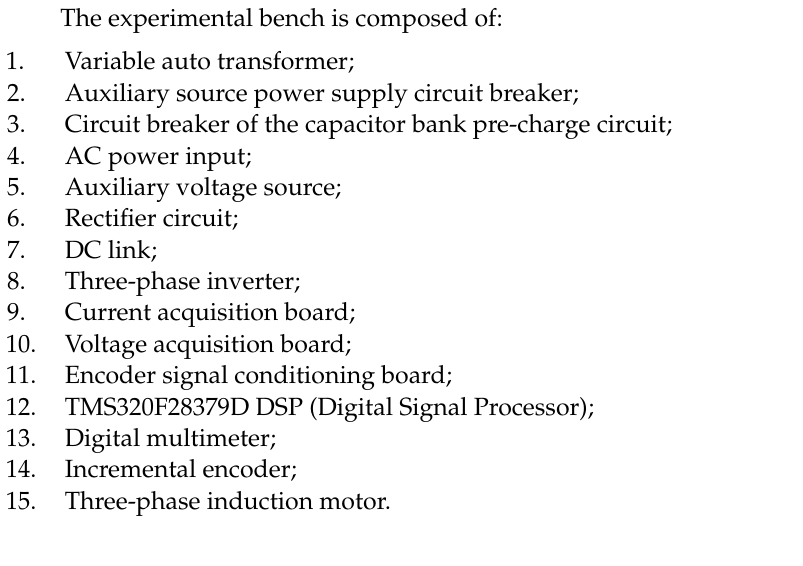
Figure 1. Experimental bench